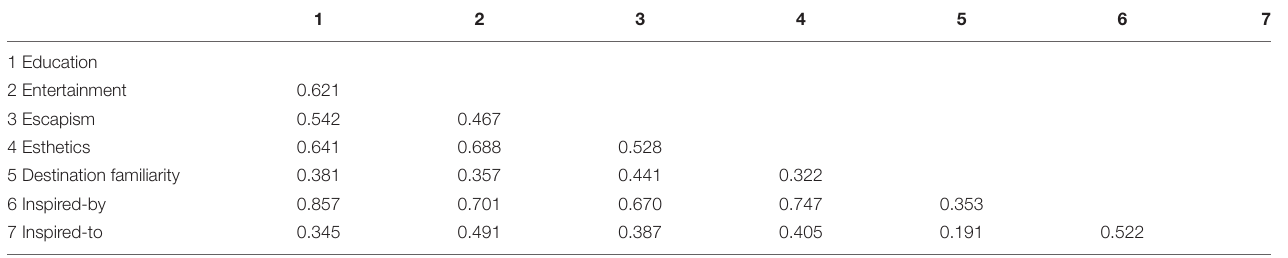
TABLE 4 | Heterotrait-monotrait (HTMT) ratio.